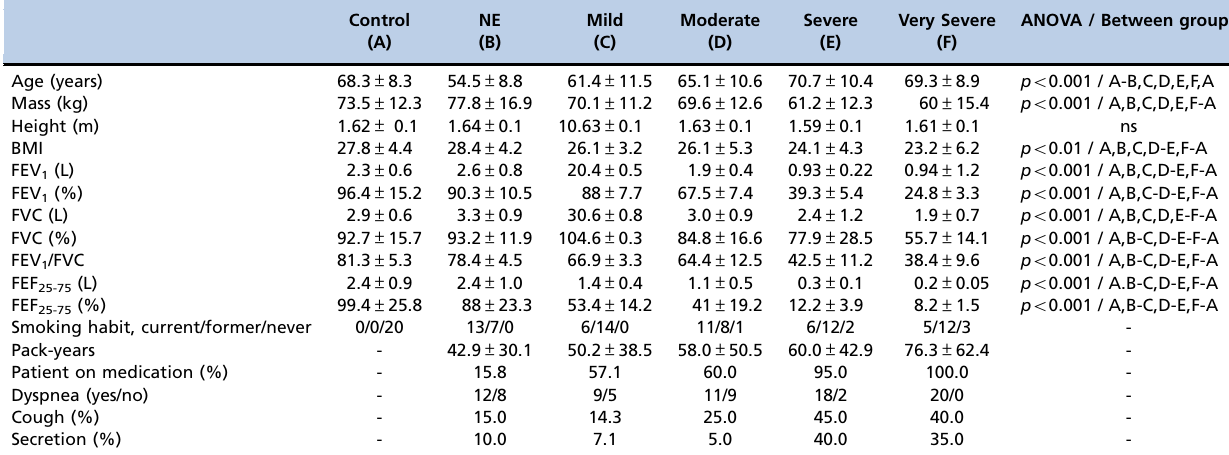
Table 1 - Biometric and spirometric characteristics of the studied groups (mean ± SD). The right column shows comparisons of the six groups/comparisons between adjacent groups; dashes indicate significant